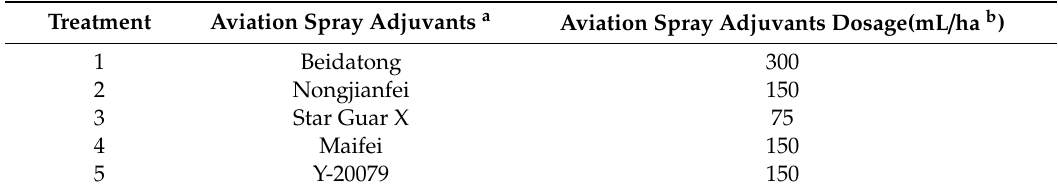
Table 2. Experimental design for screening aviation spray adjuvants.